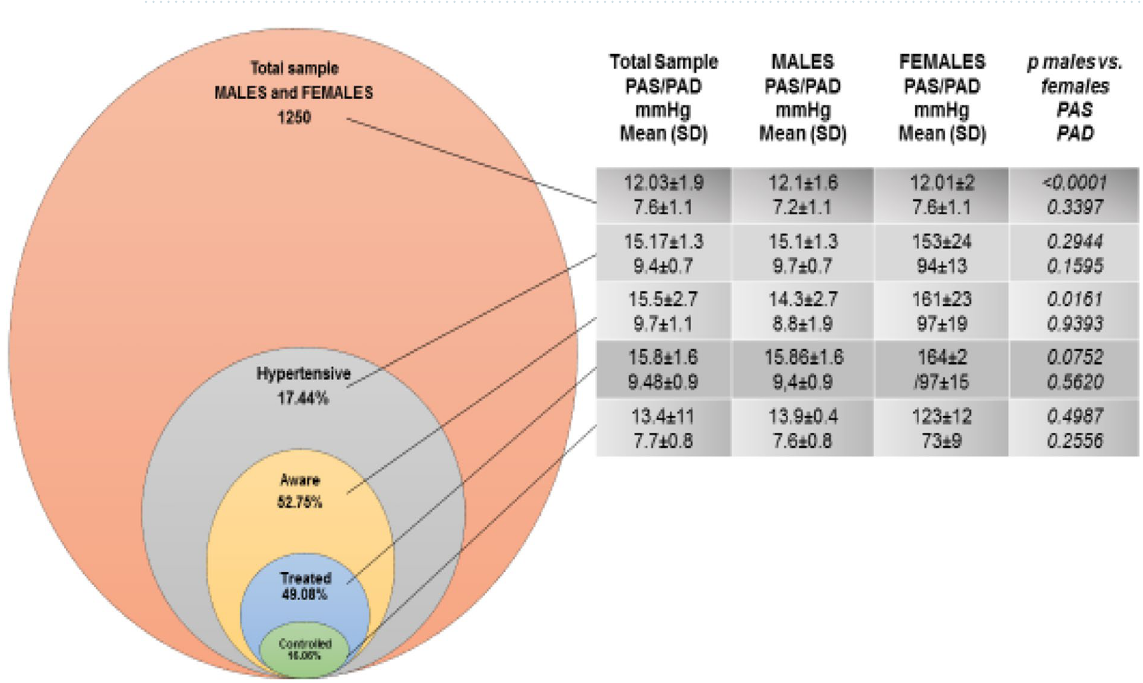
Figure 1. Hypertension awareness, treatment and control among 1250 HIV infected individuals on ART.